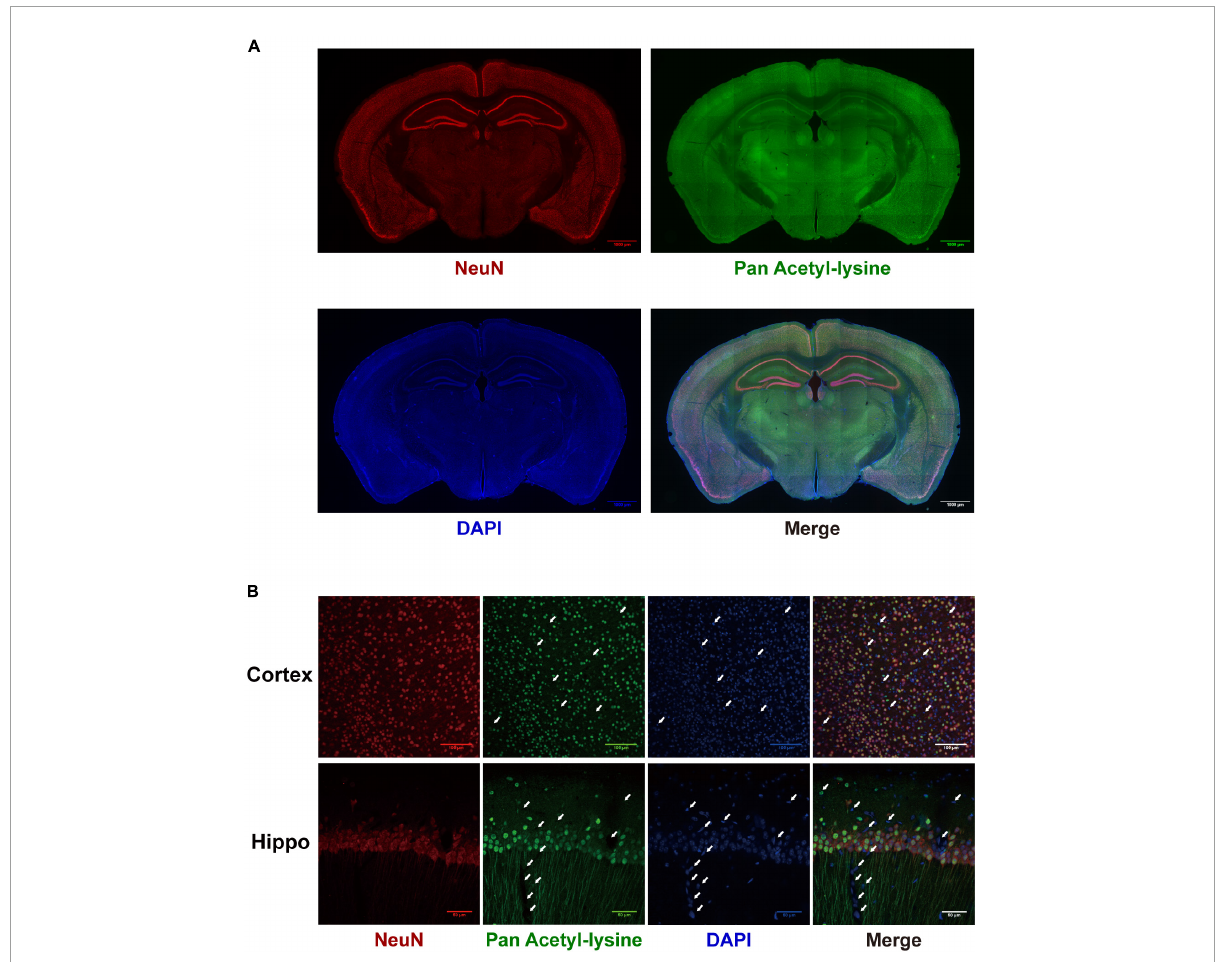
FIGURE8 The distribution of acetylated proteins in the mouse brain. (A) The co-localization of acetylated proteins (Green) with the neuron (Red) was determined by immunofluorescence in coronary sections of the mouse brain. Scale bars = 1,000 µ m. (B) Local magnification of cortex and hippocampus ( n = 3). White arrows indicated the negatively stained nuclei. Scale bar = 50 µ